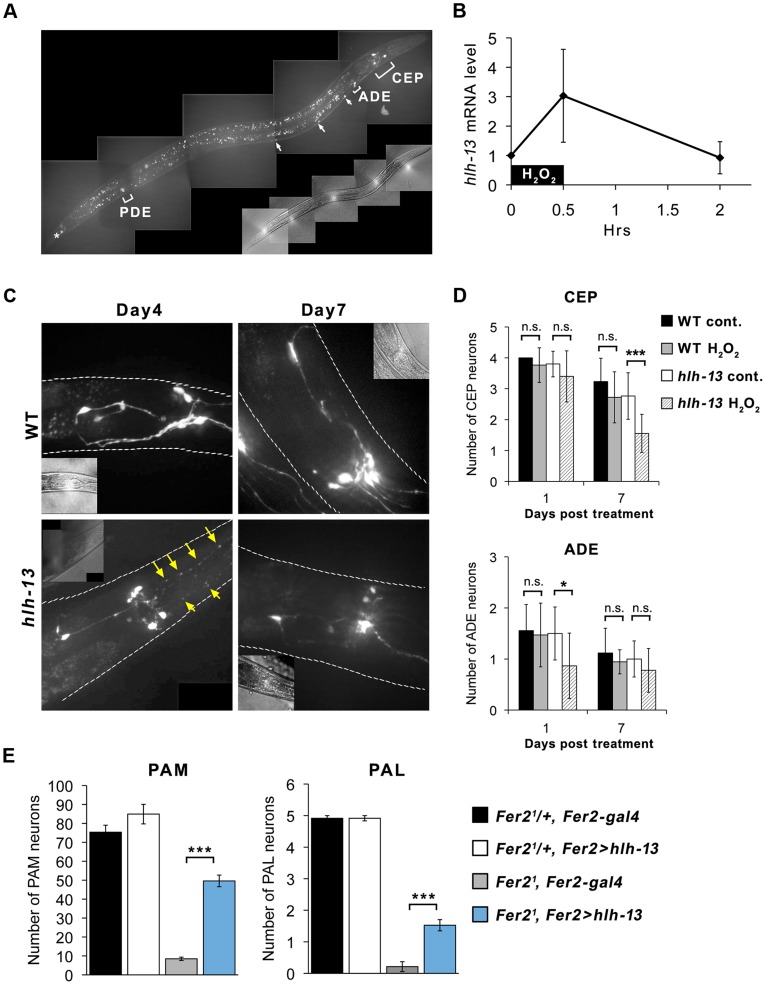

C.elegans hlh-13 and Drosophila Fer2 share a role in DA neuron protection under oxidative stress.(A) GFP::hlh-13 is expressed in DA neurons (CEP, ADE and PDE), unidentified ventral nerve cells (arrows), and in a tail neuron (asterisk). Fluorescence signal that is not labeled is the gut autofluorescence. A representative image of a L4 worm. (B) hlh-13 mRNA levels in wild-type worms after a brief 1 mM H2O2 treatment quantified by qPCR relative to the mock-treatment value. Mean from 4 independent experiments. Error bar, SEM. (C) Representative images of GFP-labeled DA neurons in the head in wild-type and hlh-13(tm2279) worms after H2O2 treatment. Arrows indicate fragmented CEP neuron projections. (D) Quantification of CEP and ADE neurons in the H2O2-treated and non-treated worms. Mean ± SEM. * p<0.05, *** p<0.001. Between 14 and 18 worms were examined for each condition. (E) Loss of PAM and PAL neurons in the Fer21 flies was significantly rescued by expressing hlh-13 with Fer2-GAL4. Fer21/+, Fer2-gal4: n = 13. Fer21/+, Fer2 > hlh-13: n = 13. Fer22, Fer2-gal4: n = 16. Fer21, Fer2 > hlh-13: n = 22. 1-day-old flies. Mean ± SEM. *** p<0.001.